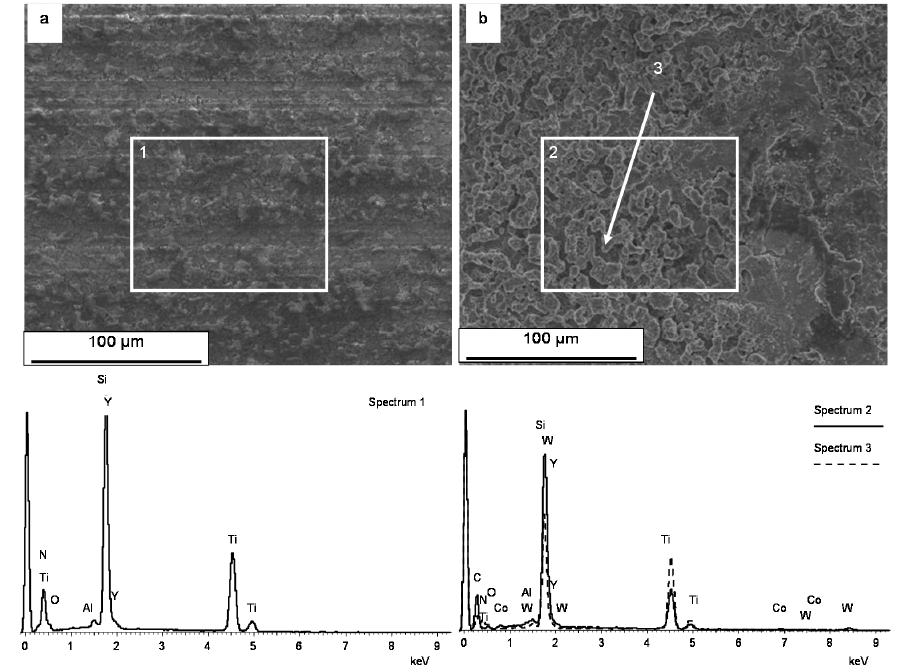
Figure 13. SEM-EDS characterization of Diamond Tool Machining (DTM) ( a ) and micro-EDM ( b )